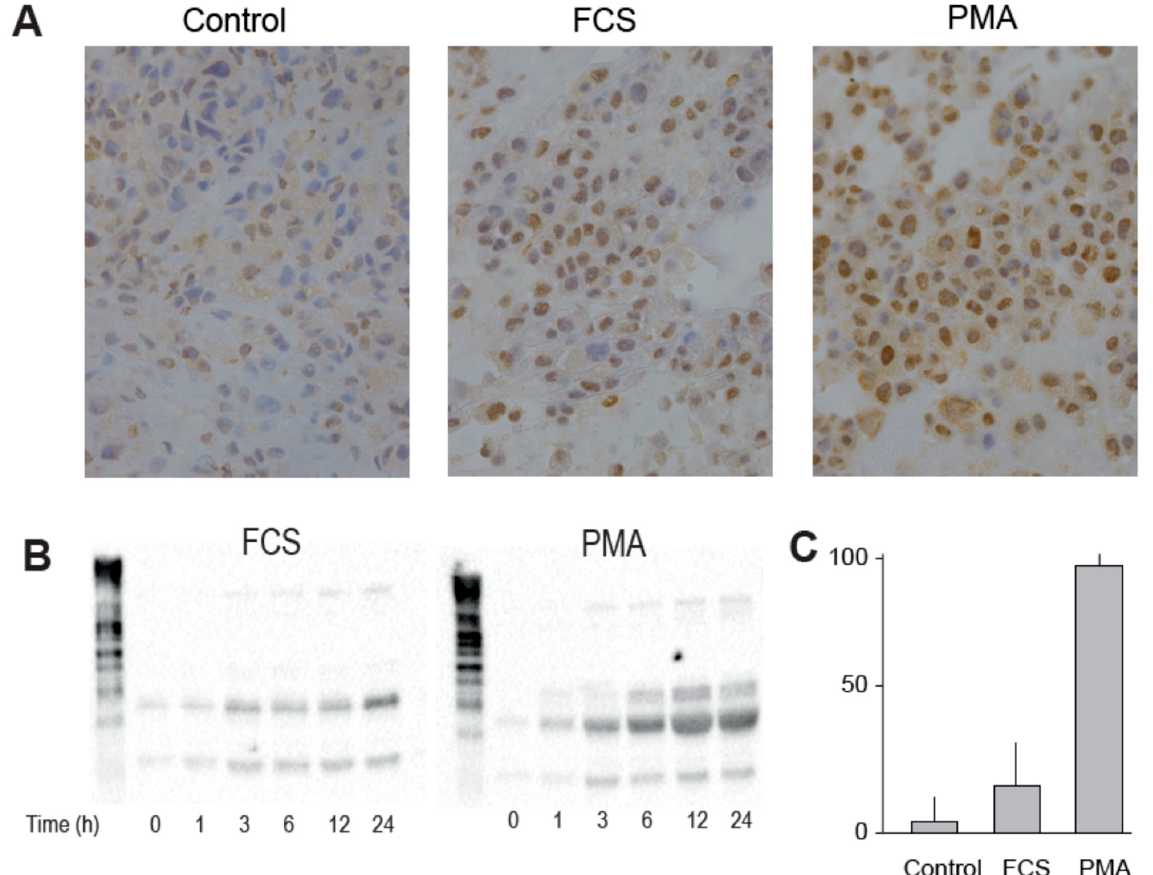
Figure 2. ( A ) Increased nuclear staining for LINE1 after treatment with FCS and PMA compared to untreated HepG2 cells. ( B ) Increased LINE1 protein expression as measured by western blotting. ( C ) Increased LINE1 translocation index as measured for nuclear presence of LINE1 protein.